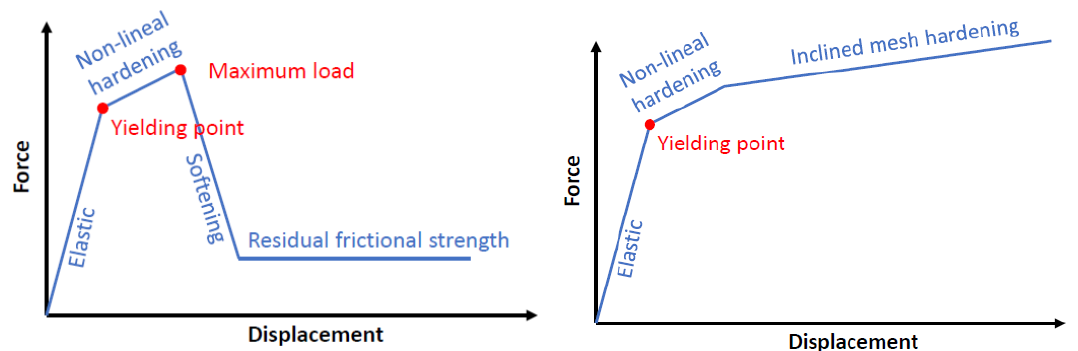
Figure 10. Idealization of the behavior of a straight ( left ) mesh connection and an inclined ( right ) mesh connection.